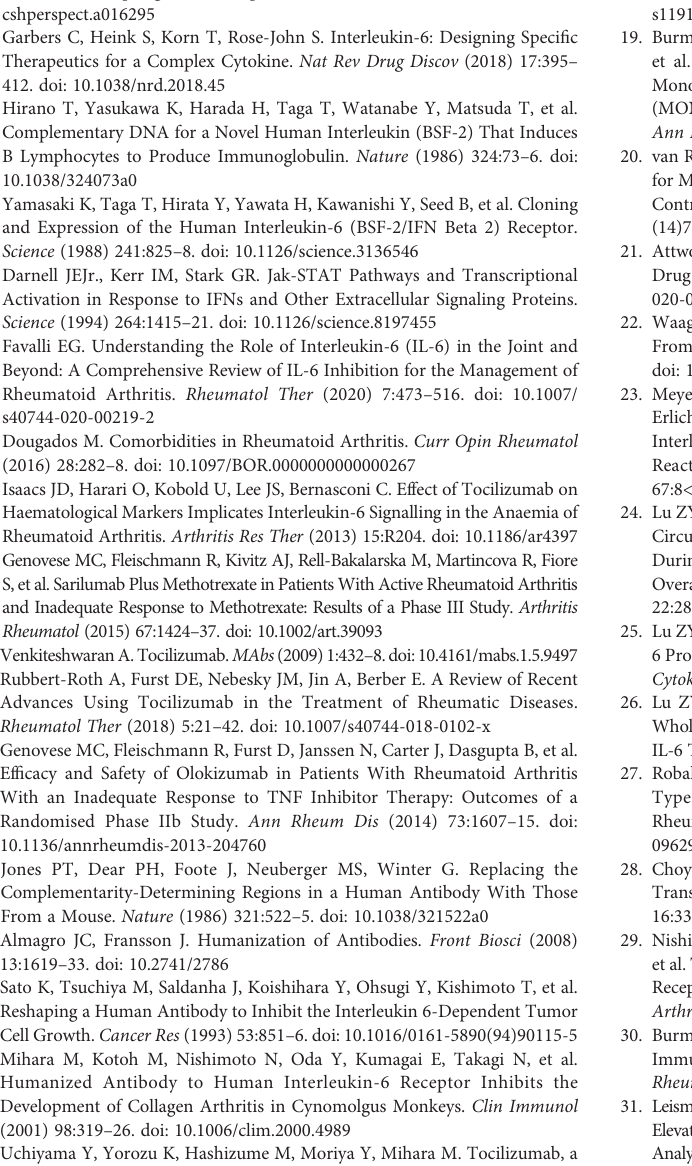
Supplementary Figure 1 | Cross-reactivity of HZ-0408b to other cytokines and GP130.96-wellplateswerecoatedwithindicatedcytokinesandGP130.Increasing concentrations of HZ-0408b were added and the binding activity of the HZ-0408b was measured by ELISA using an HRP-conjugated anti-HZ-0408b antibody.